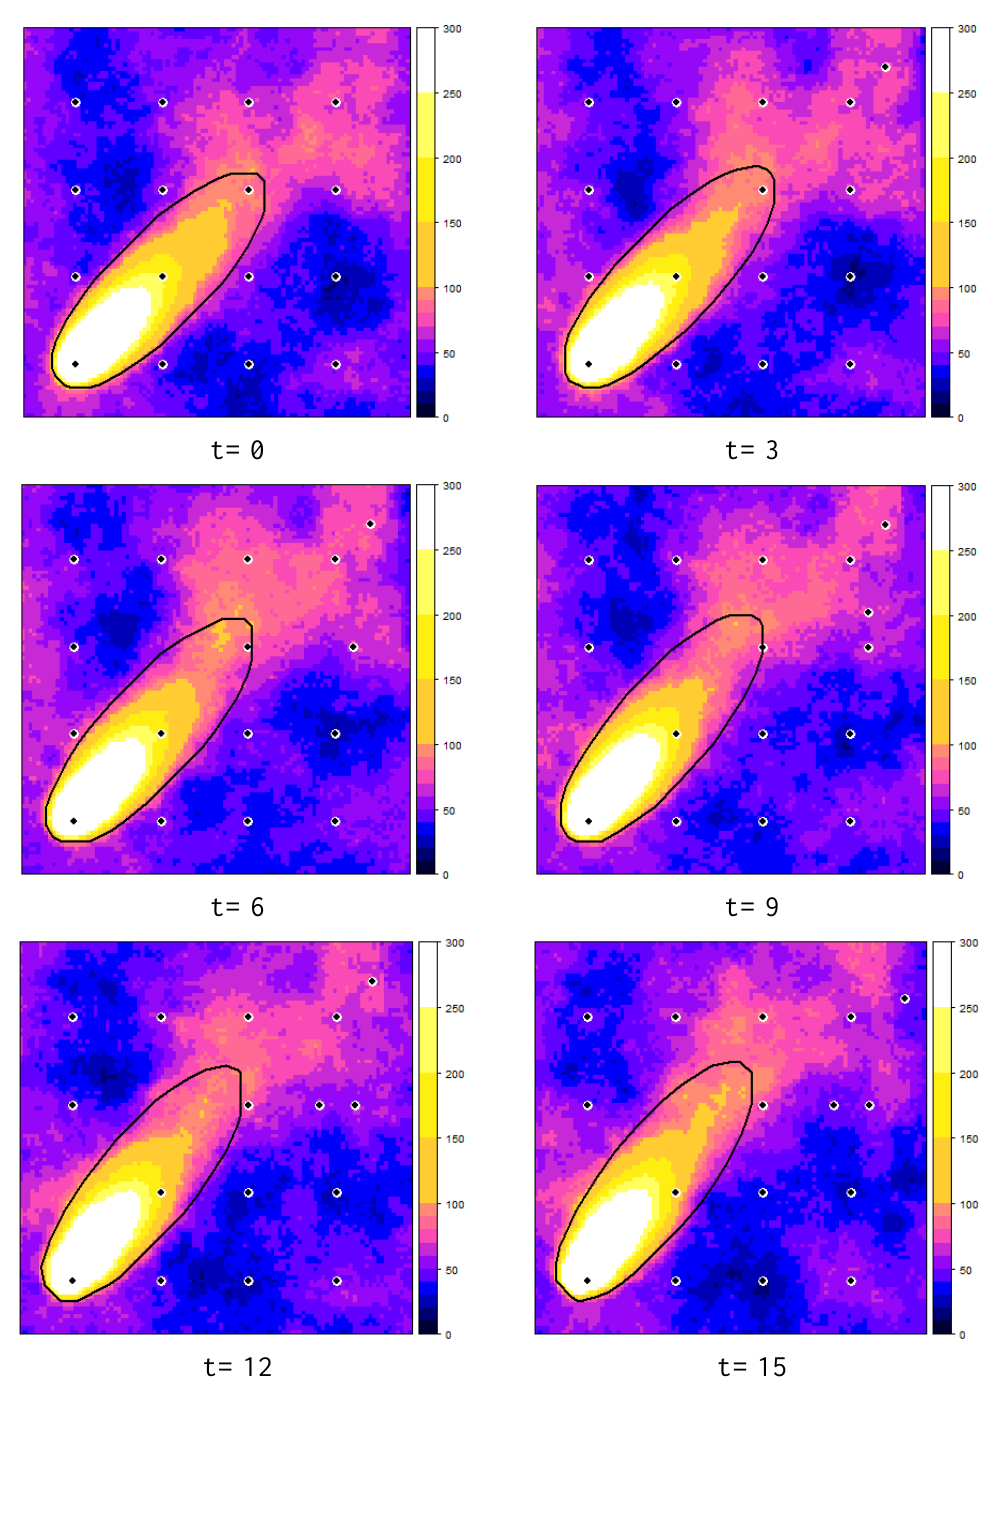
Figure 6. EVOI sampling of a dynamic plume (ppm), with single sensor relocation per time step. The black line delineates the critical level for the deterministic plume; black/white dots are the sensor